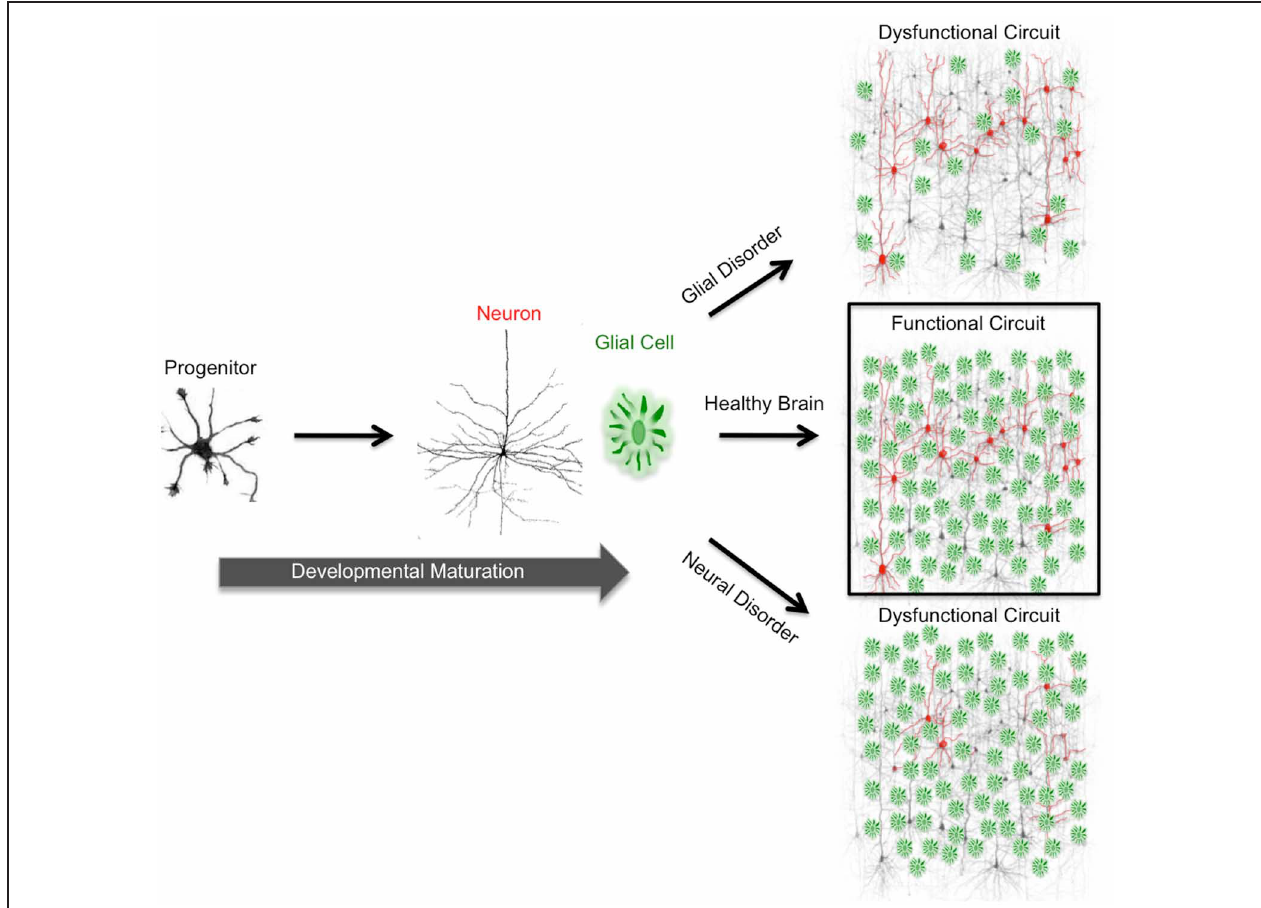
cells give rise to neurons and glia. In neurodevelopmental and neurodegenerative disorders, proper neuron and glial interactions do not occur due to cellular malfunction. This malfunction impairs functional circuit formation and leads to circuit dysfunction. Impaired neuronal circuits are implicated in a wide variety of disorders such as epilepsy, Alzheimer’s, Parkinson’s, and Huntington’s